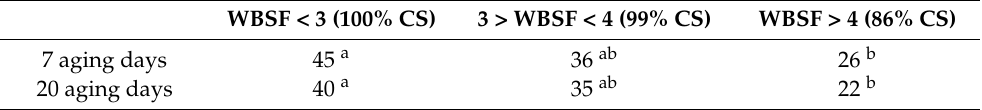
Table 4. Temperament index according to WBSF (kgF) by category. Least square